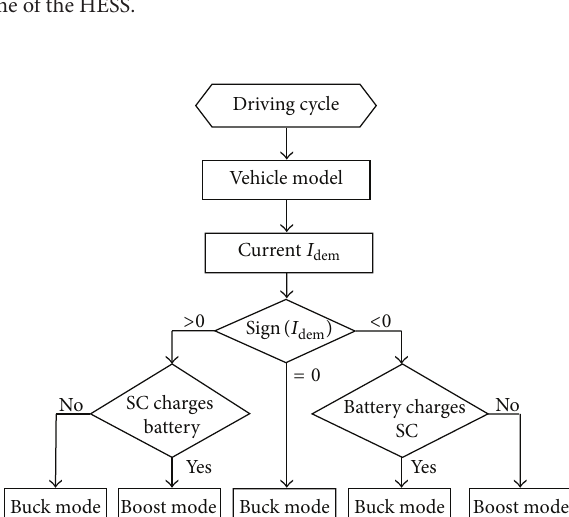
Figure 6: Control frame of the HESS.